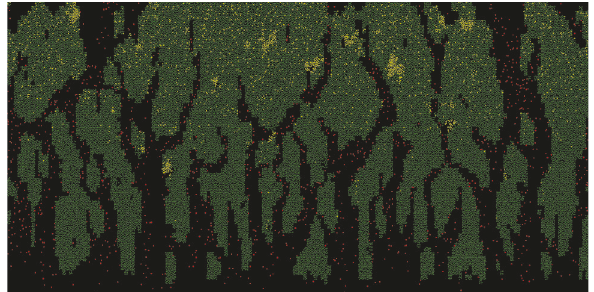
Figure 14: Result of the vegetation model for the ecological model area where green is Spartina, red is Salicornia, and yellow is Aster.